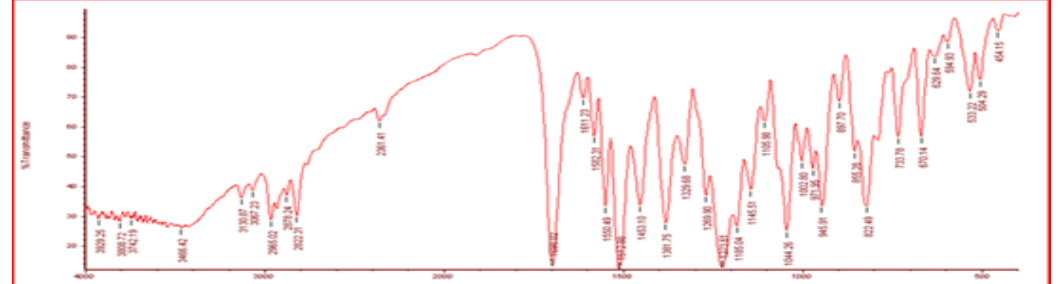
Figure 11. FTIR spectrum of pure